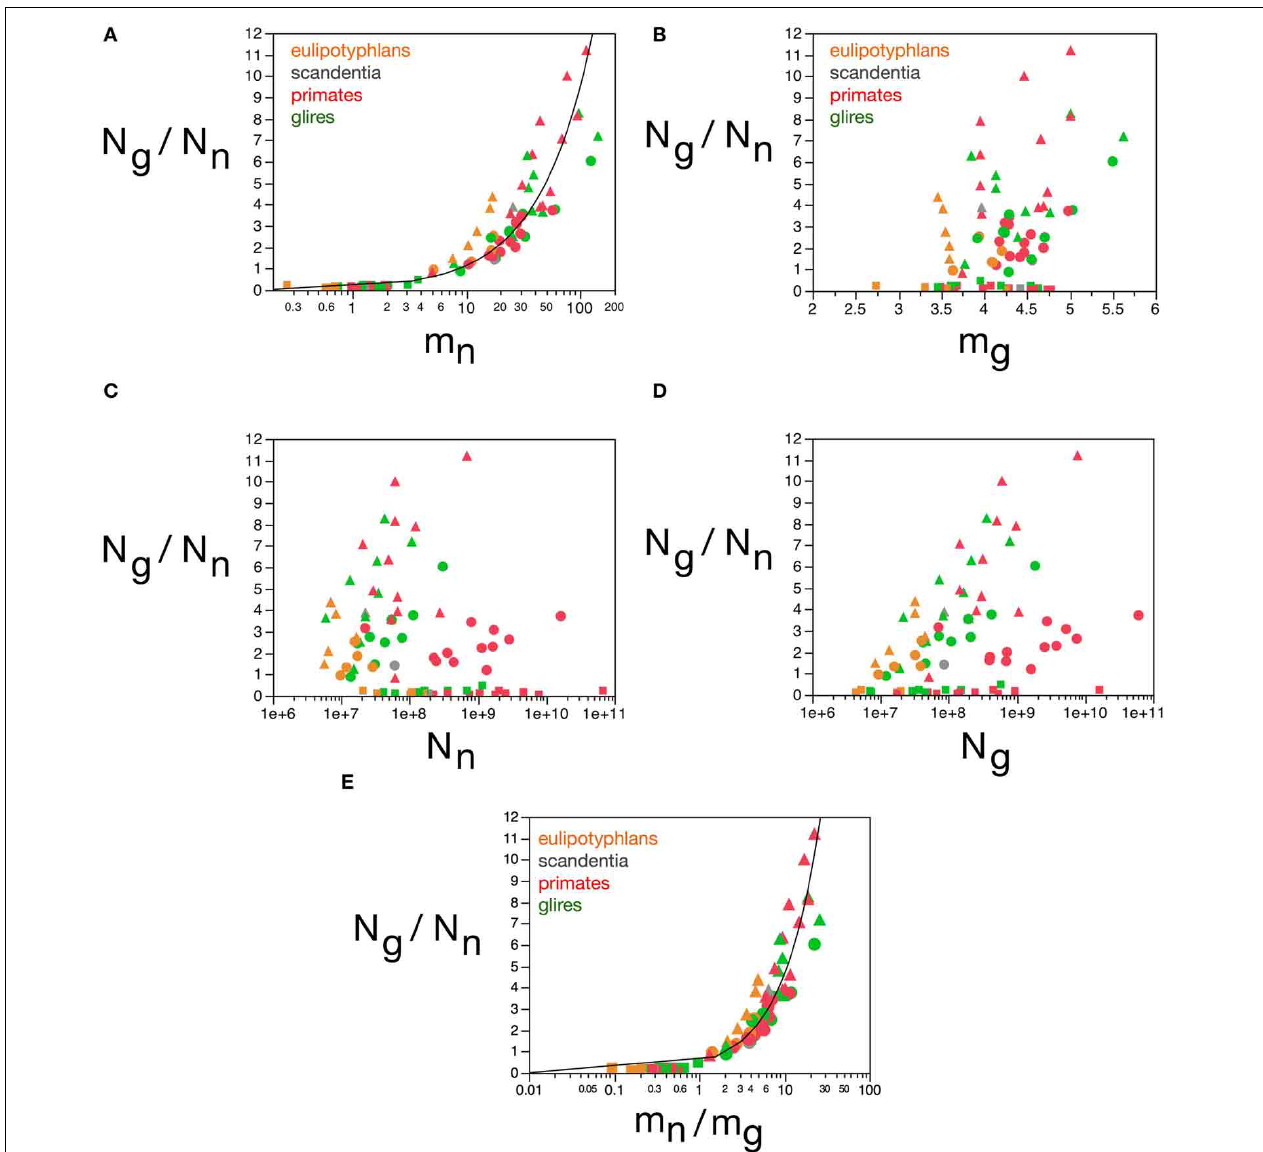
estimated average neuronal cell mass (A) and, even better, by the ratio between average neuronal and average glial cell mass in the structure. All masses in picograms. Functions plotted are (A) N g /N n = 0.137 ( m n ) 0 . 922 ± 0 . 035 ( r 2 = 0 . 898, p < 0 . 0001) and (E) N g /N n = 0.487 ( m n /m g ) 0 . 977 ± 0 . 030 ( r 2 = 0 . 929, p < 0 . 0001). Cerebral cortex plotted as circles, cerebellum as squares, and rest of brain as triangles; eulipotyphlans shown in orange, primates in red, and rodents in green. Data from Herculano-Houzel et al. (2006, 2007, 2011), Azevedo et al. (2009), Sarko et al. (2009), and Gabi et al.